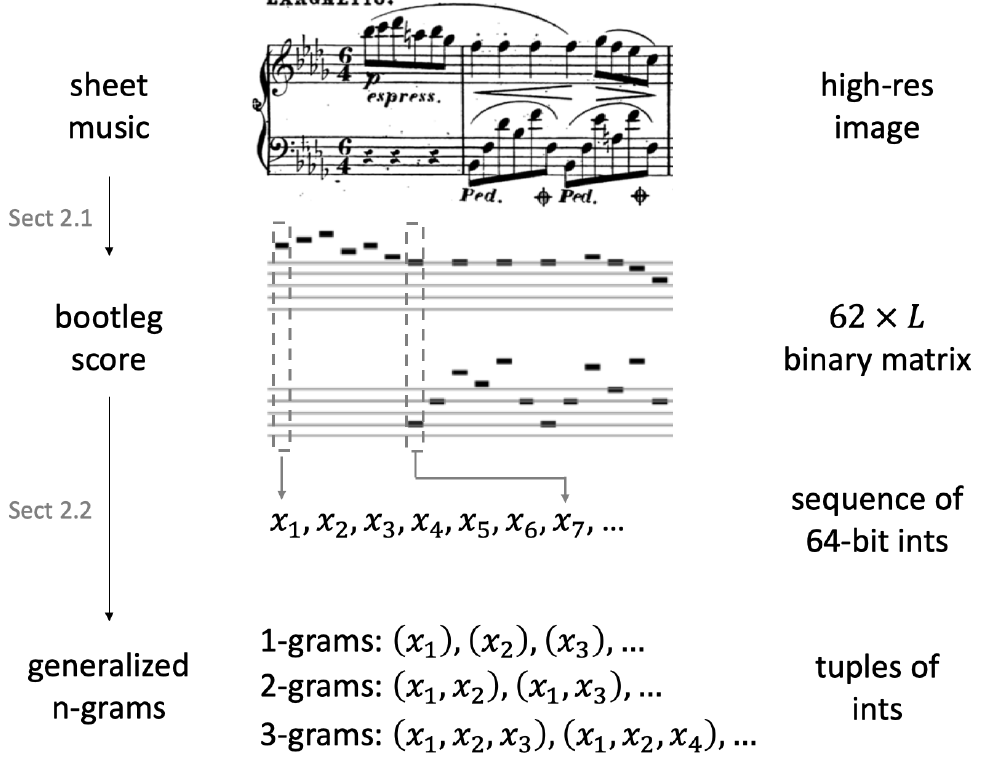
Figure 2. Overview of constructing generalized n-gram fingerprints from sheet music. Whereas standard n-grams only consider n consecutive elements, generalized n-grams consider combinations of n elements from a fixed context